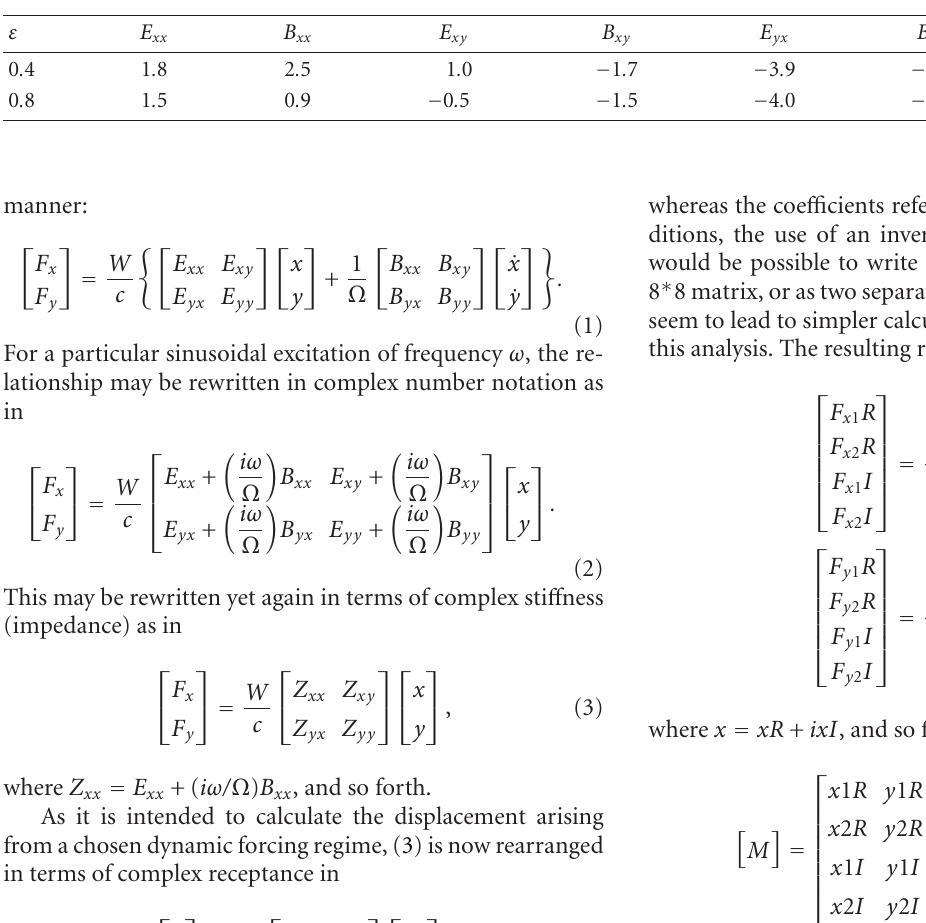
Table 1: Selection of coe ffi cients. Note that in this representation x is horizontal and y is